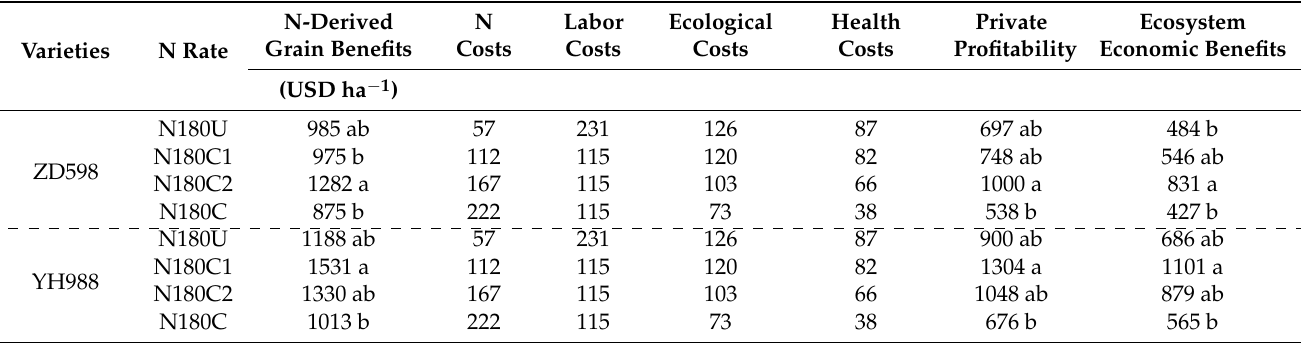
Table 3. Ecosystem economic benefits of summer maize under different N t treatments and maize verities across